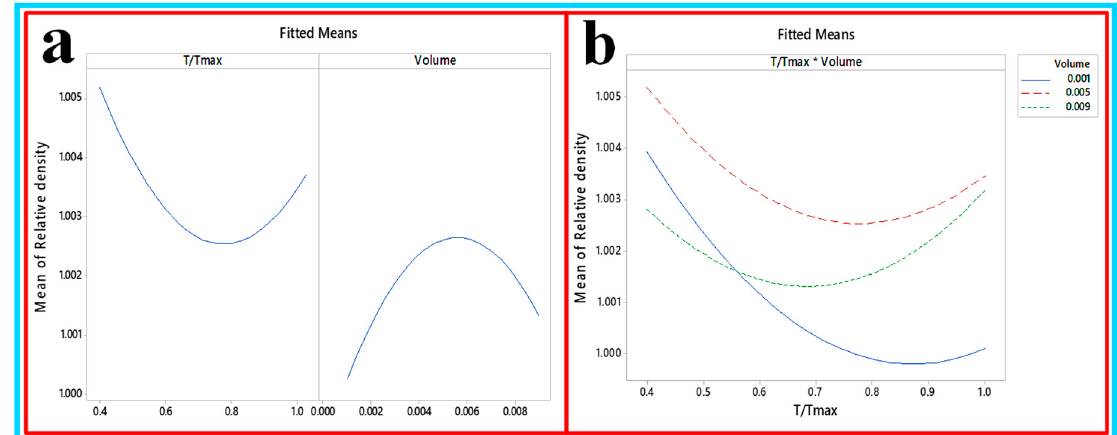
Table 7. ANOVA for specific heat.